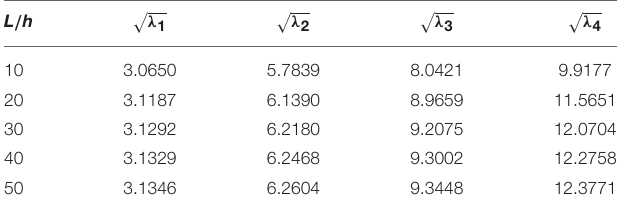
√ λ for CC case for different (cid:17) (cid:16)